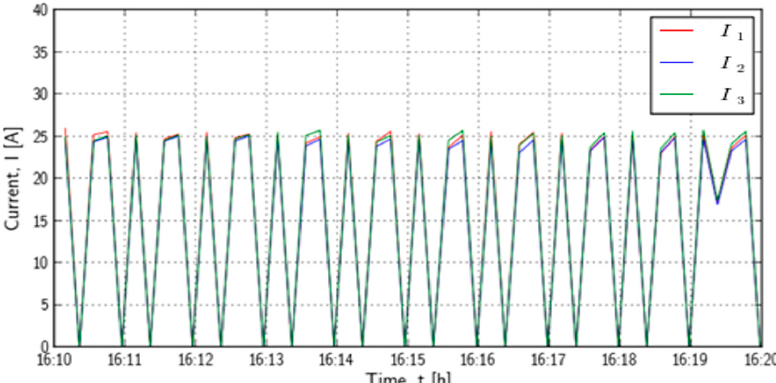
Figure 20. The diagrams of the load current changes of PU2 recorded on 21 June 2009. (Zoomed in period 16:10–16:20).